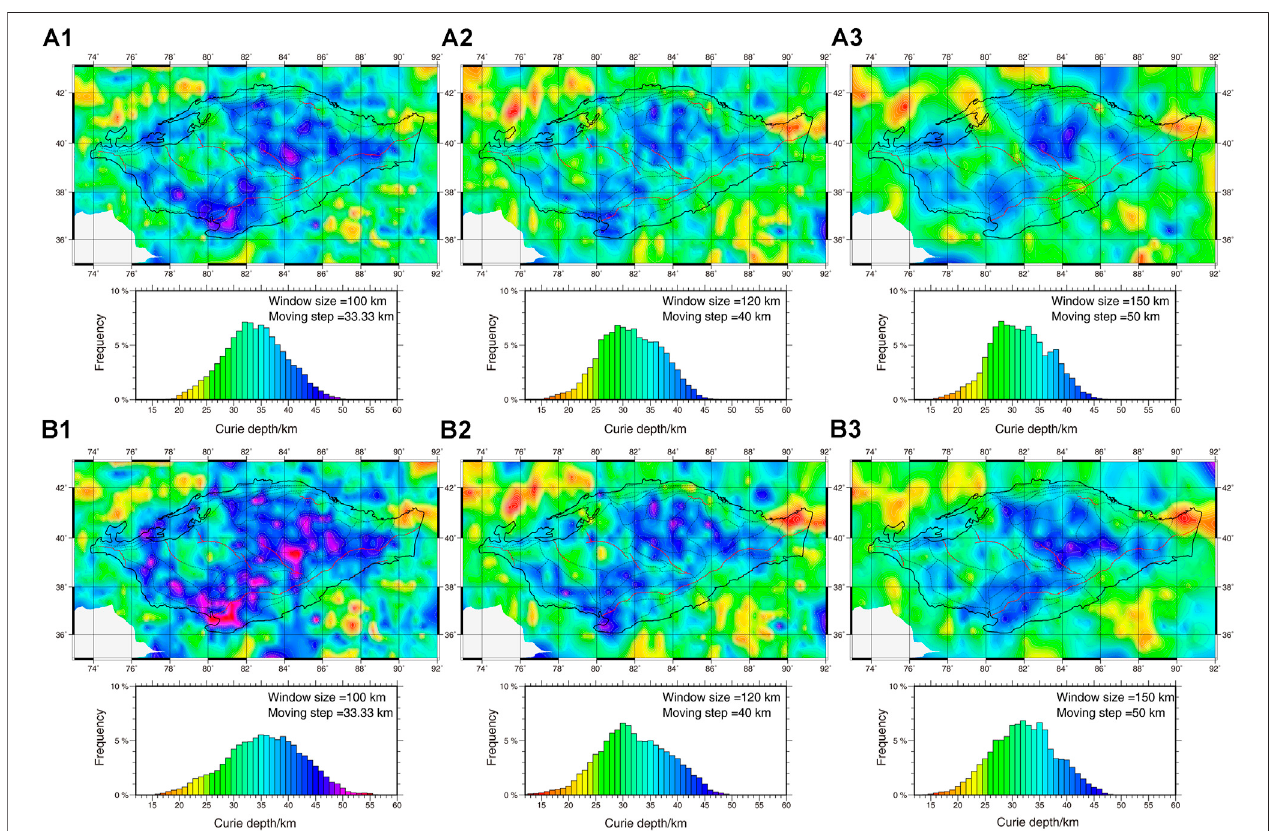
FIGURE 4 | The spatial variations in the CPD over the Tarim Basin and surrounding areas using three different windows with two wavenumber bands selected for linear fi tting by using least square method to calculate Z t and Z 0 : ca. 0.0237 ∼ 0.0334 and ca. 0.015 ∼ 0.033 km − 1 (A) ; ca. 0.0237 ∼ 0.0334 and ca. 0.0335 ∼ 0.0526 km − 1 (B) , respectively. Window sizes: (1) 100 × 100 km 2 , (2) 120 × 120 km 2 , (3) 150 × 150 km 2 . The distributions of estimated CPD values from the centroid method in these tests have been plotted below the corresponding Curie surface